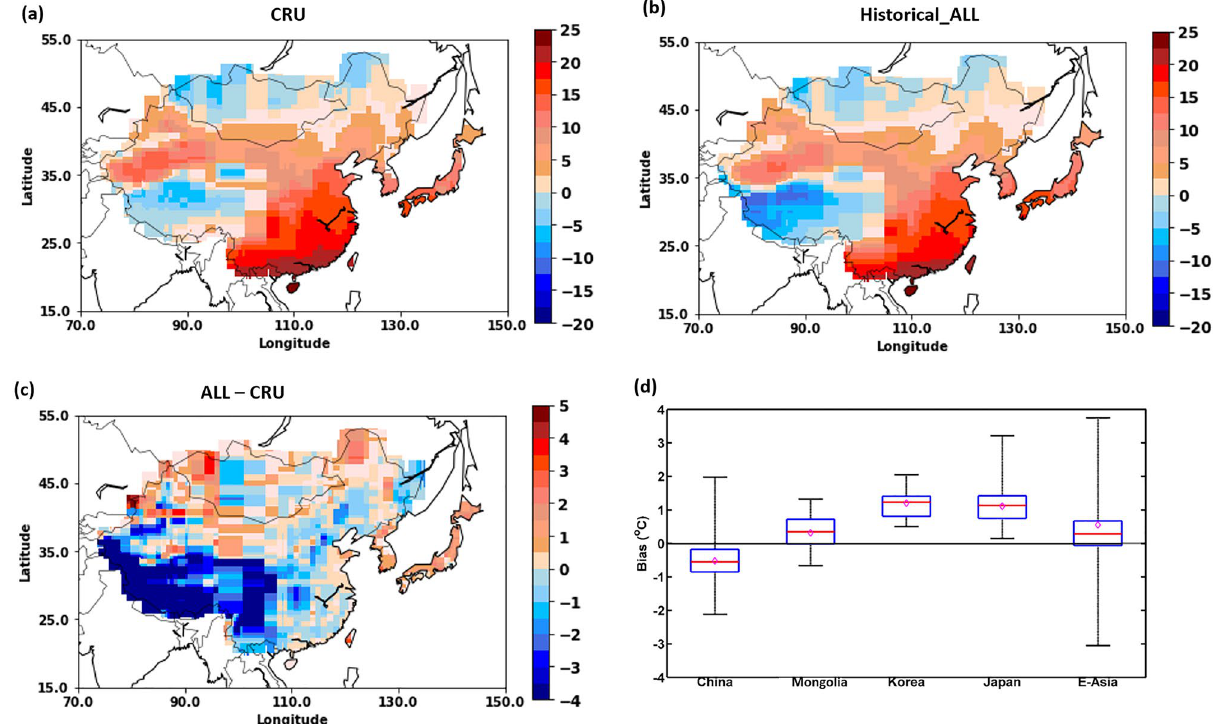
Figure 1. Annual mean temperatures from 1901 to 2014. ( a ) CRU, ( b ) multi-model ensemble mean of surface air temperature responses to ALL (anthropogenic and natural) forcing obtained from CMIP6. ( c ) Bias between ALL and CRU (ALL − CRU) across EA. ( d ) Bias (ALL − CRU) boxplots showing 5% (bottom of the whisker), 25% (bottom edge of the box), mean (diamond), median (central red line), 75% (top edge of the box), and 95% (top of the whisker) values. All figures were generated using licensed MATLAB (release R2017b available at https:// in. mathw orks. com/ produ cts/ matlab.